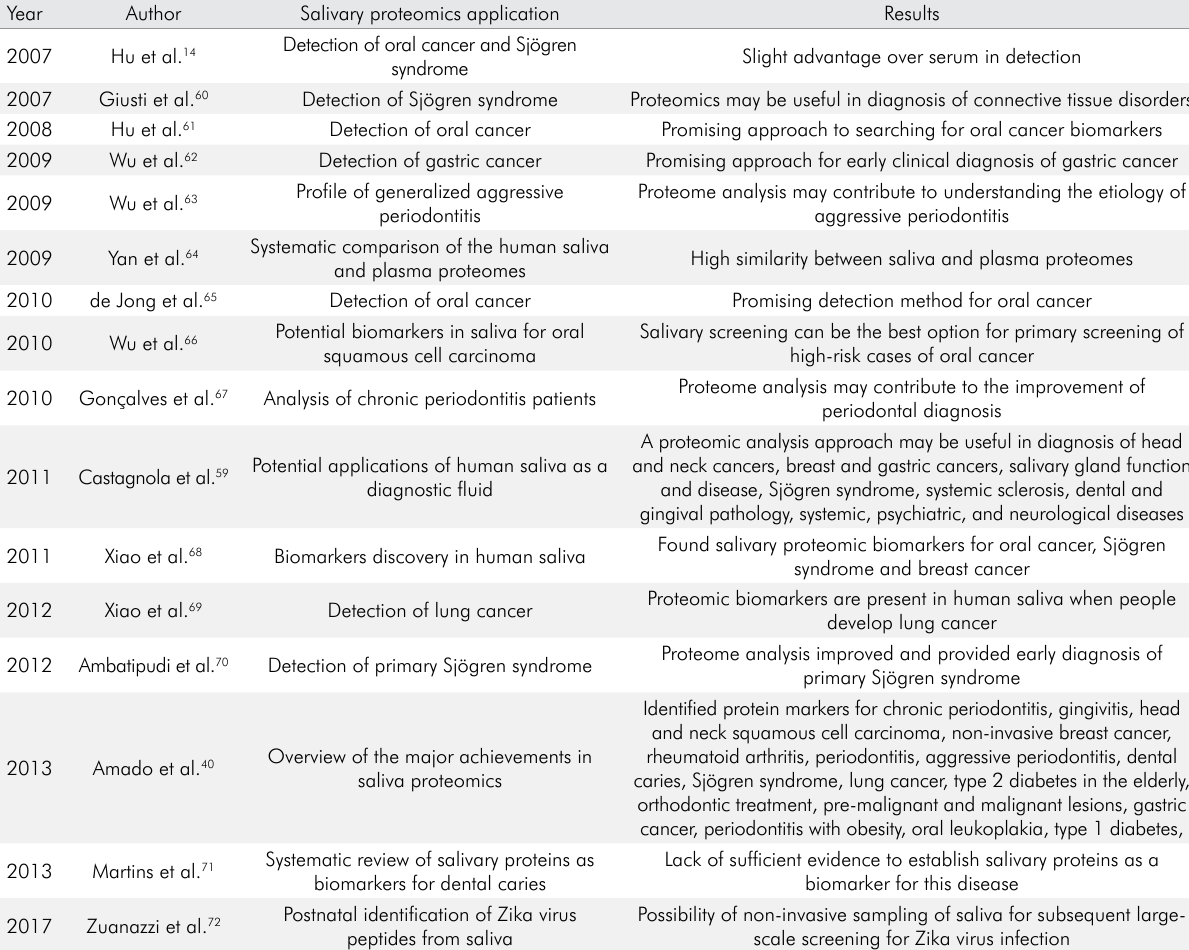
Table 1. Highly-cited articles on disease detection using salivary proteomics.